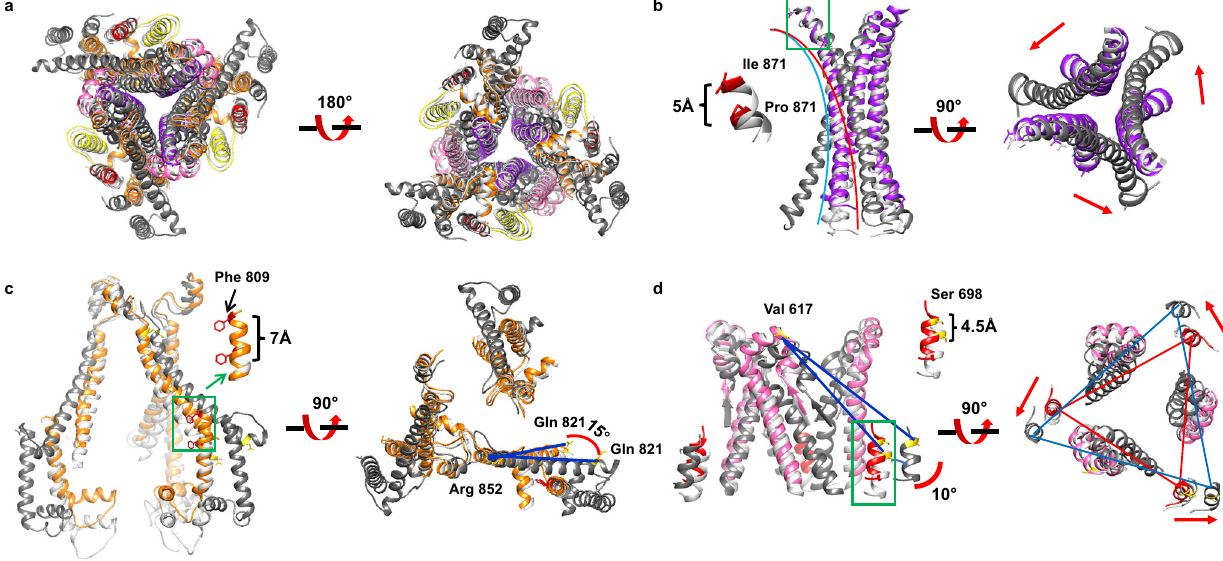
Fig. 3 Structural comparison of HCoV-229E spike S2 subunit in different conformaitons reveals closed-to-open conformational changes. a Overall structural comparison of the S2 subunit from C1, C2, and the previously reported open HCoV-229E S protein (PDB ID: 6U7H). b Zoomed-in comparison of CH. The CH is twisted outward relatively to the symmetry axis gradually from C1 to C2 to open HCoV-229E S protein with twister angles of − 78°, − 78.2° and − 86°, respectively. c Close-up views of HR1. The Phe in helix (residues Gln791-Phe809) of C2 goes upward 7 Å compared to that of C1. The helix (residues Gln821-Arg852) of open HCoV-229E S protein rotates outward by 15° Compared to that of C1 (similar to C2). d Structural comparison of FP. The FP of C2 goes upward 4.5 Å relatively with that of C1 and can be further exposed with a clockwise rotation of about 10° from C1 to the open HCoV-229E S protein. C1 and the previously reported open S protein (PDB ID: 6U7H) are colored in gray and dark gray, respectively. The C2 is colored as Fig. 1a. Some loops between the secondary structures are omitted for clari fi